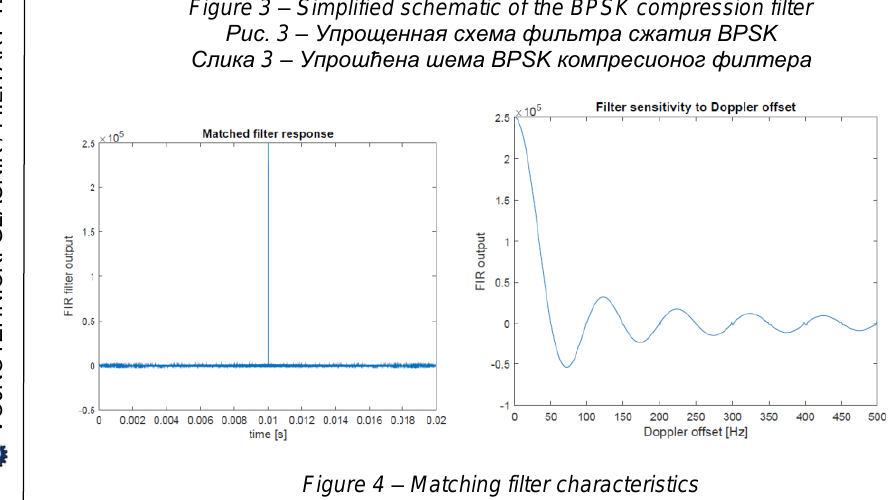
Figure 4 – Matching filter characteristics Рис. 4 – Характеристики согласованного фильтра Слика 4 – Карактеристике прилагођеног